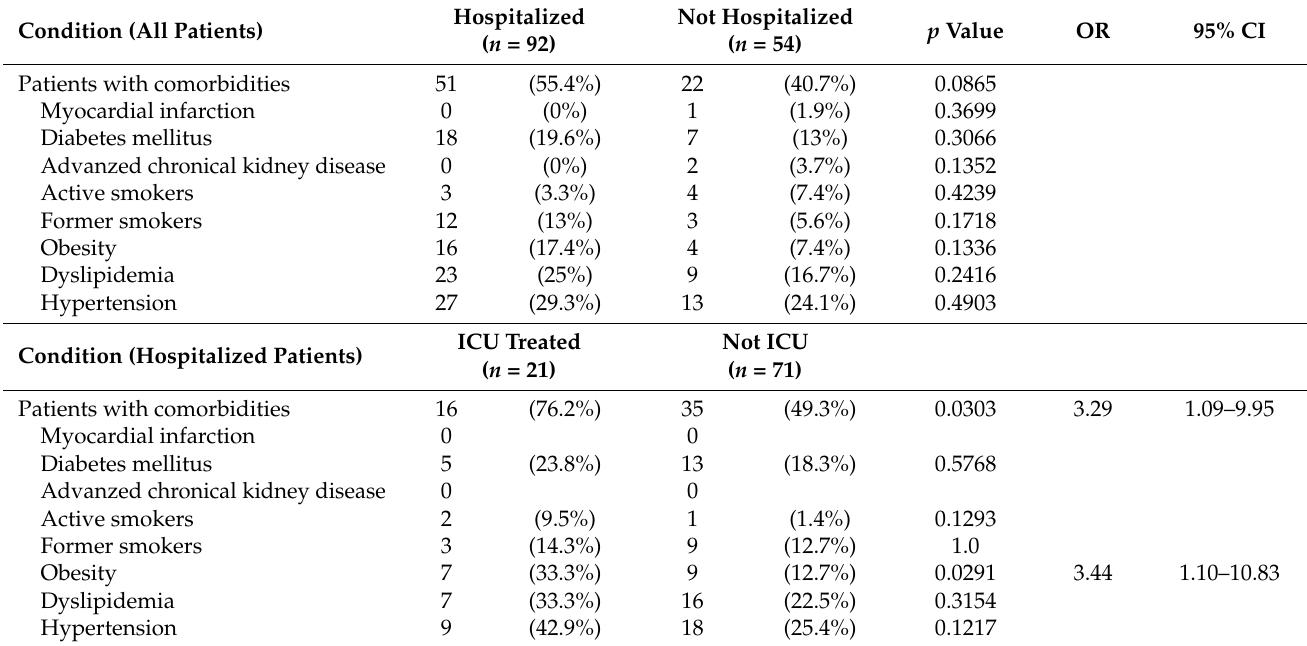
Table 3. Comorbidities in hospitalized vs. non-hospitalized patients (upper zone) and in those hospitalized patients who required admission to the ICU (lower